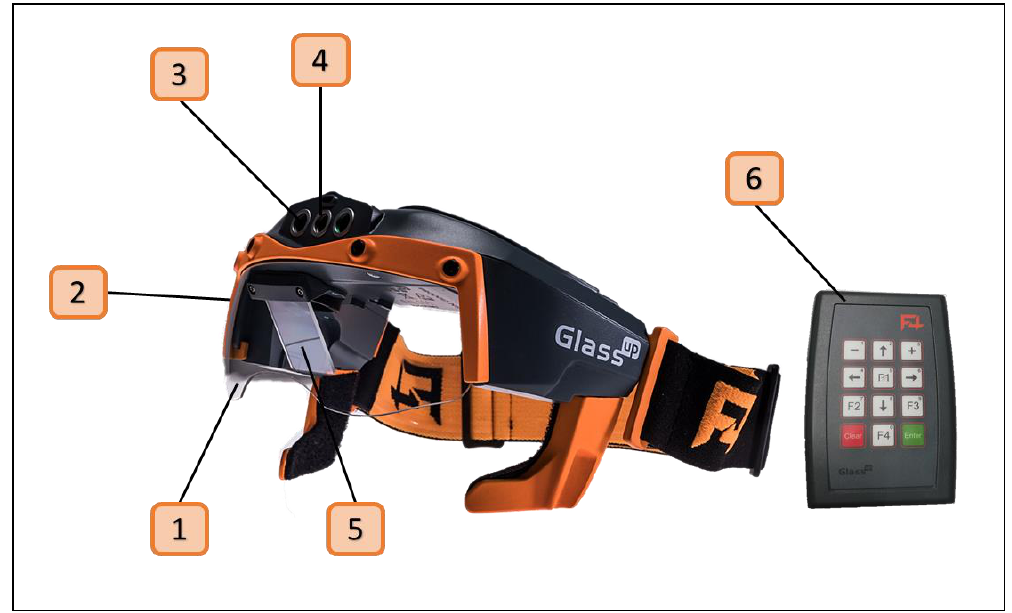
Figure 1. GlassUp F4 smartglasses used in this study: ( 1 ) frontal protection lens; ( 2 ) right side key button; ( 3 ) video / photo camera; ( 4 ) front light; ( 5 ) optical system / see-through display; ( 6 ) joypad “box”.